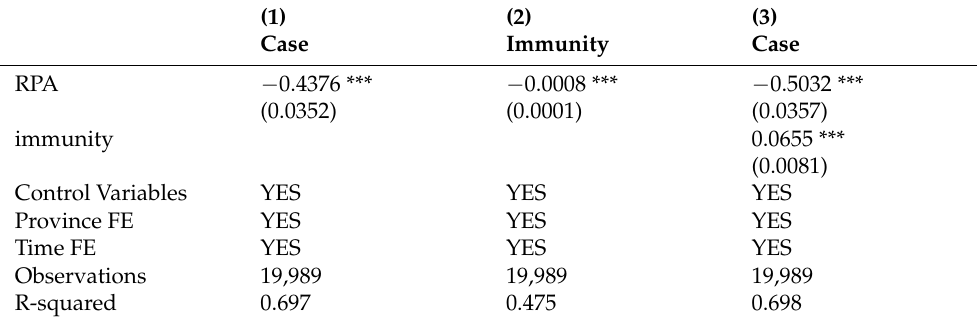
Table 4. Mechanism test.